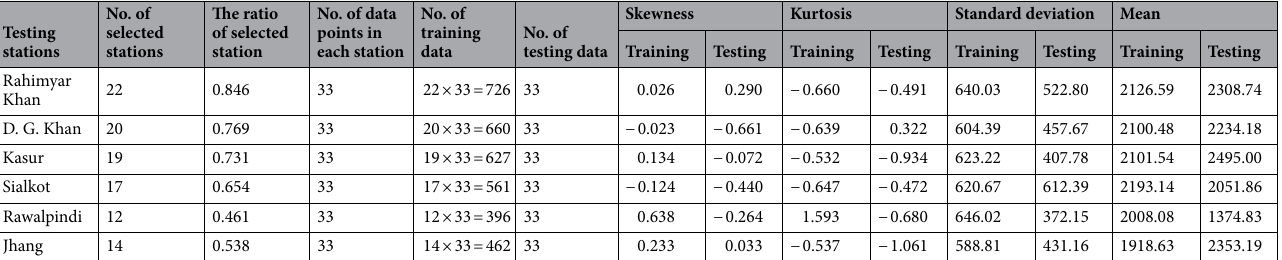
Table 3. Training data points (in terms of selected training stations) and testing data points for each testing station using the ACO algorithm. The ratio of selected stations against testing stations, skewness, and kurtosis of training and testing